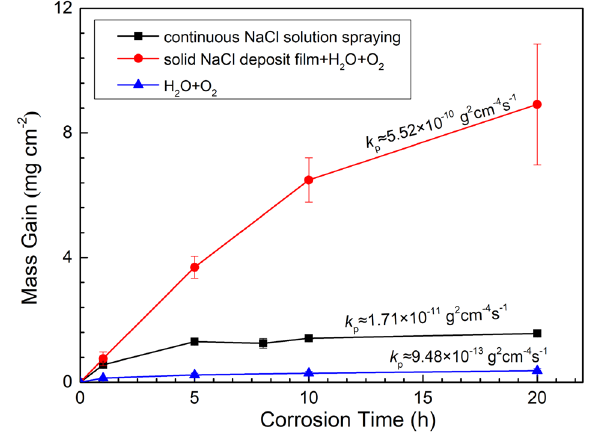
Fig. 1 Mass gain curves of Ti exposed to different environments for 20 h at 600 °C. Continuous NaCl solution spraying ( ), solid NaCl deposit fi lm + H 2 O + O 2 ( ), H 2 O + O 2 ( ). Error bars represent standard deviations.